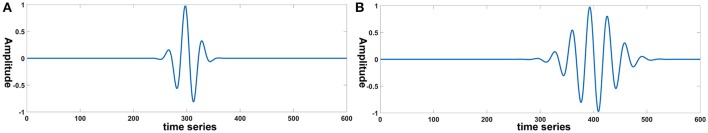
Simulated signal generating two coherent sources where the X-axis represents the sample points, and the Y-axis presents the amplitude of signal. (A) The waveform of source 1. (B) The waveform of source 2.